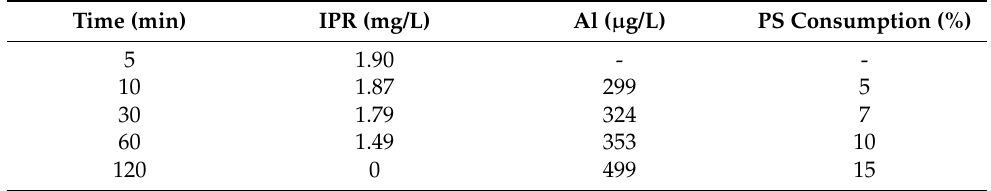
Table 2. IPR abatement, Al release, and PS consumption observed during ZVA/PS treatment of